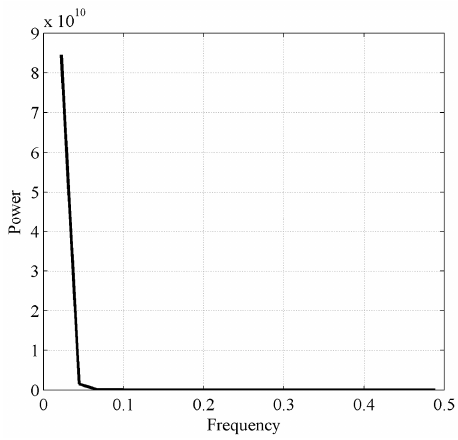
Figure 10. Power spectrum of IMF4 for Zhaishang station.